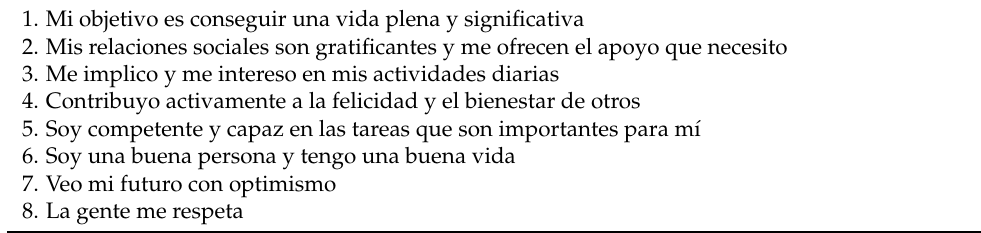
Table A1. Colombian version of the Flourishing